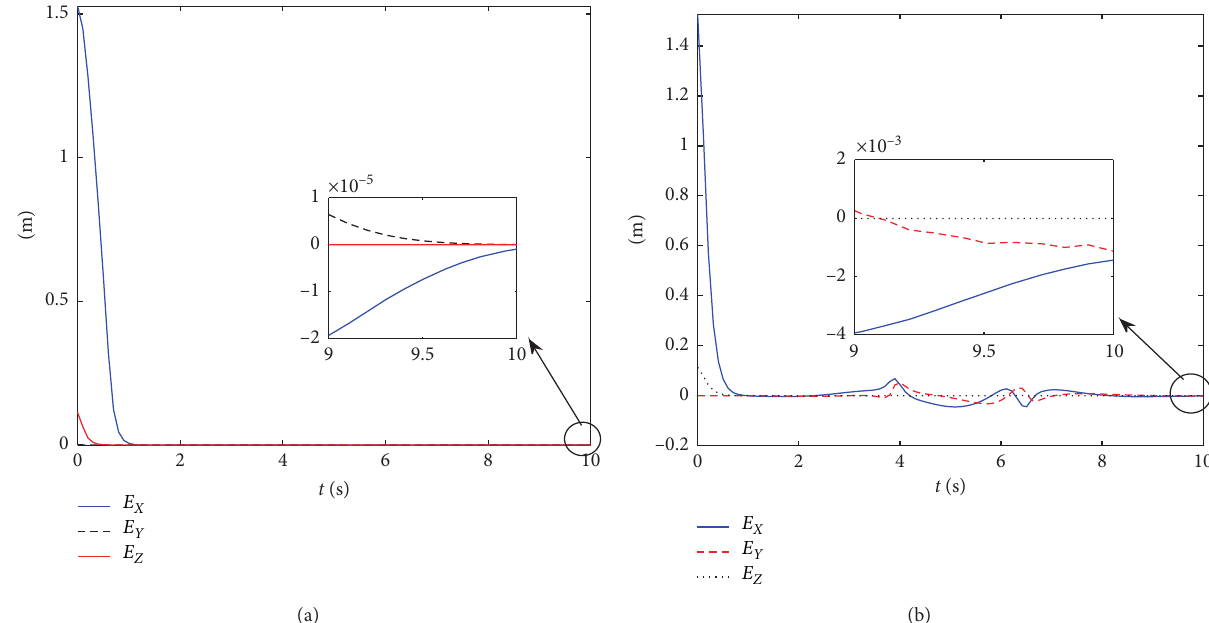
Figure 7: Synthesized positioning errors of the end effector by the EVPNN model and ZNN model when completing the task of the cardioid path. (a) EVPNN model. (b) ZNN model.